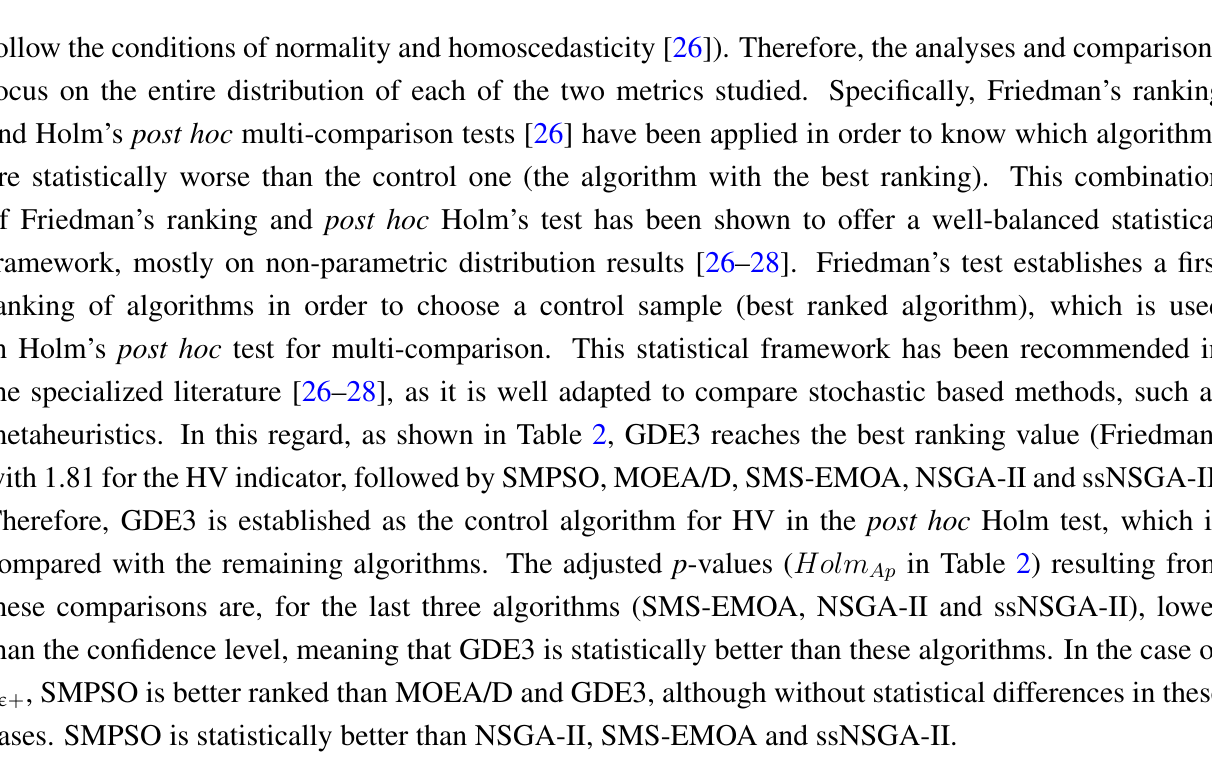
Table 2. Average Friedman’s rankings with Holm’s adjusted p -values ( α = 0 . 05 ) of the for the test set of 11 docking instances. * indicates the control algorithm, and the column at the right contains the overall ranking of positions with regards to I